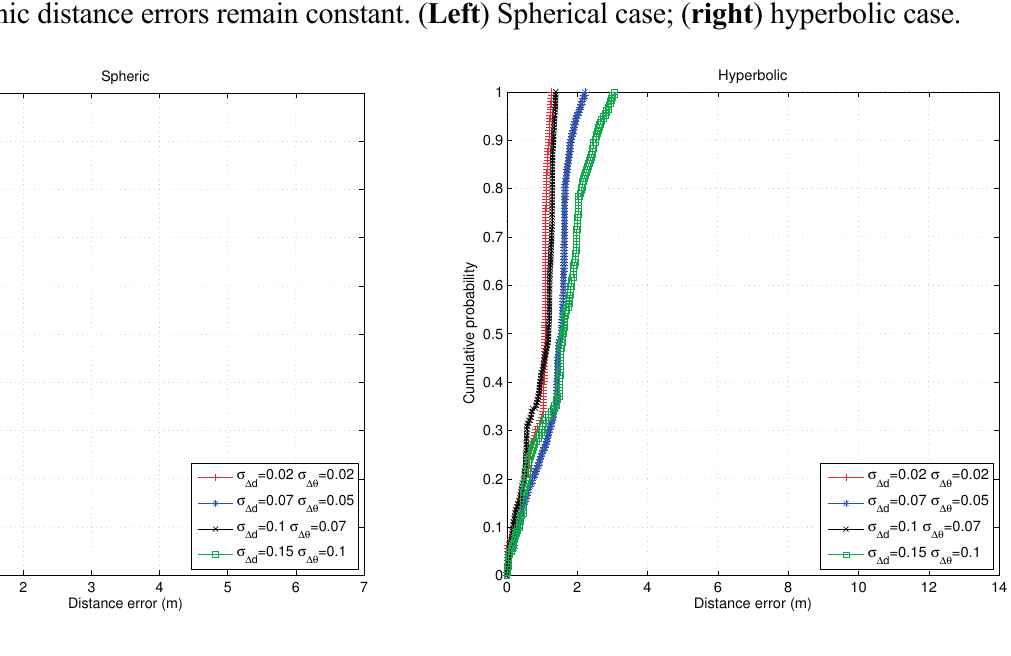
Figure 8. cdf of the navigation errors for different odometry error conditions assuming that the ultrasonic distance errors remain constant. ( Left ) Spherical case; ( right ) hyperbolic